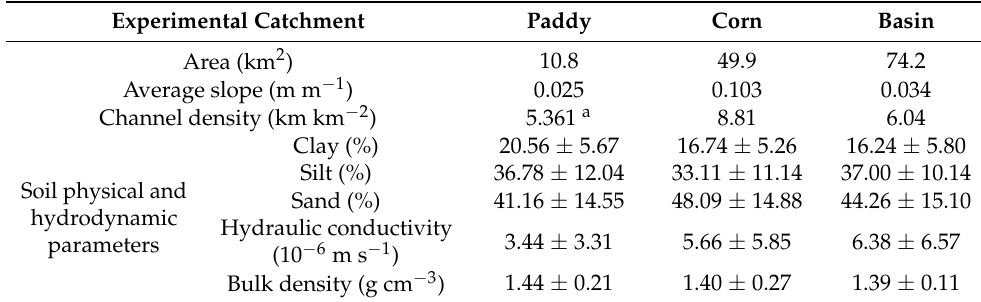
Table 1. Basic information of the Heidingzi river basin. Experimental Catchment